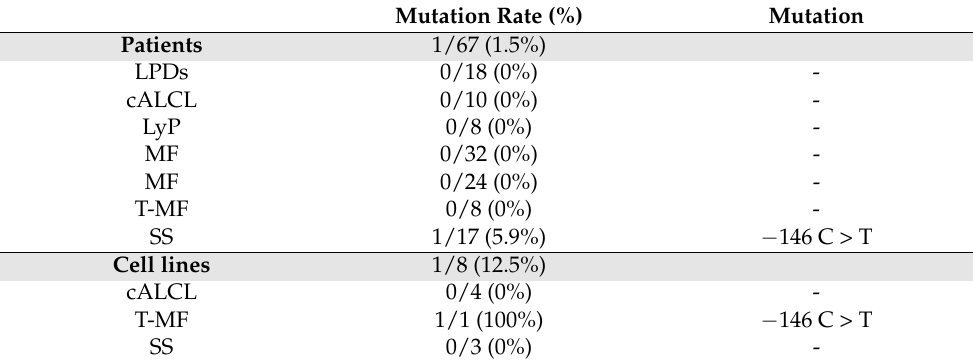
Table 2. hTERT promoter mutations analysis in CTCL